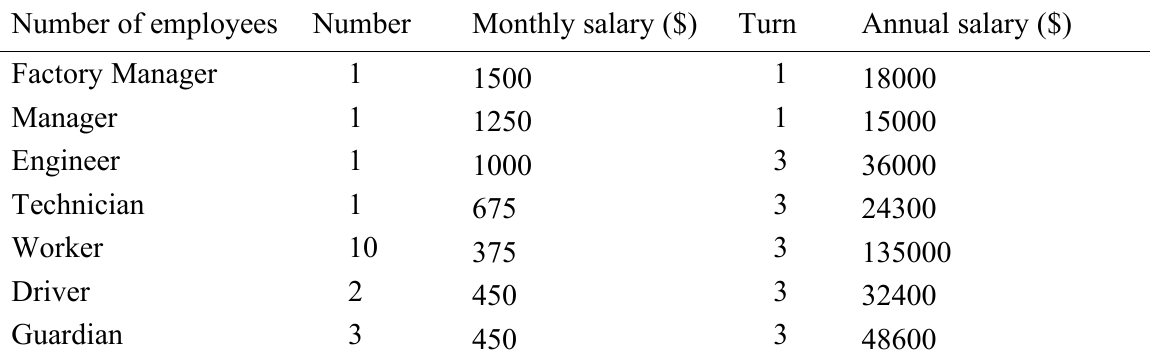
Table 10. Manufacturing staff costs